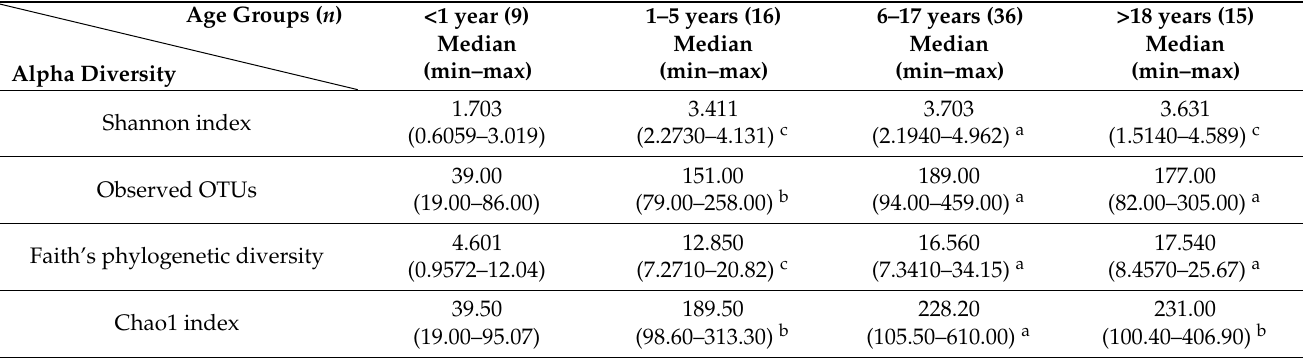
Figure 1. Differences between age groups. ( A ): UniFrac distances among infants and other age groups. The samples were visualized using principal coordinate analysis (PCoA). Differences with other age groups are statistically significant. ( B ): The plot of top 15 relative bacterial abundances at genus level. The statistical significances are shown in Table S1A. Table 4. Alpha diversity indices in the age